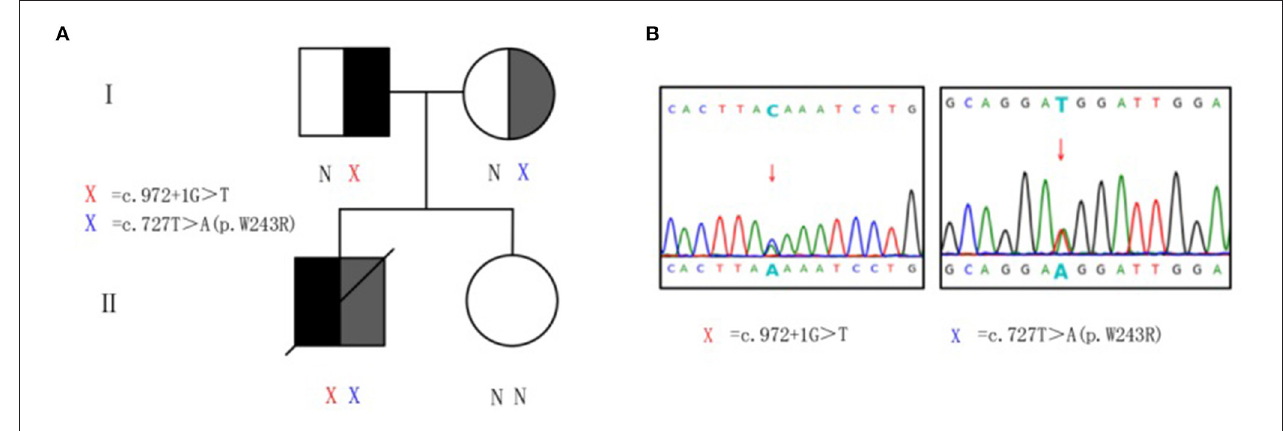
FIGURE 2 | Heterozygous mutations of HSD17B4 in the family. (A) Pedigree of family with D-bifunctional protein (DBP) deficiency. X, variant; N, normal. (B) Sanger sequencing validation of HSD17B4 variants identified by exome sequencing. For the mutated gene c.972 + 1G > T, the sequencing validation is reversed, and the complementary chain of G > T is C > A. Genomic DNA was amplified for sequencing with primers flanking intron 12 and exon 10. Arrow indicates heterozygous mutations. Red X, c.972 + 1G > T at chr5:119496647–119496647. Blue X, c.727T > A (p.W243R) at